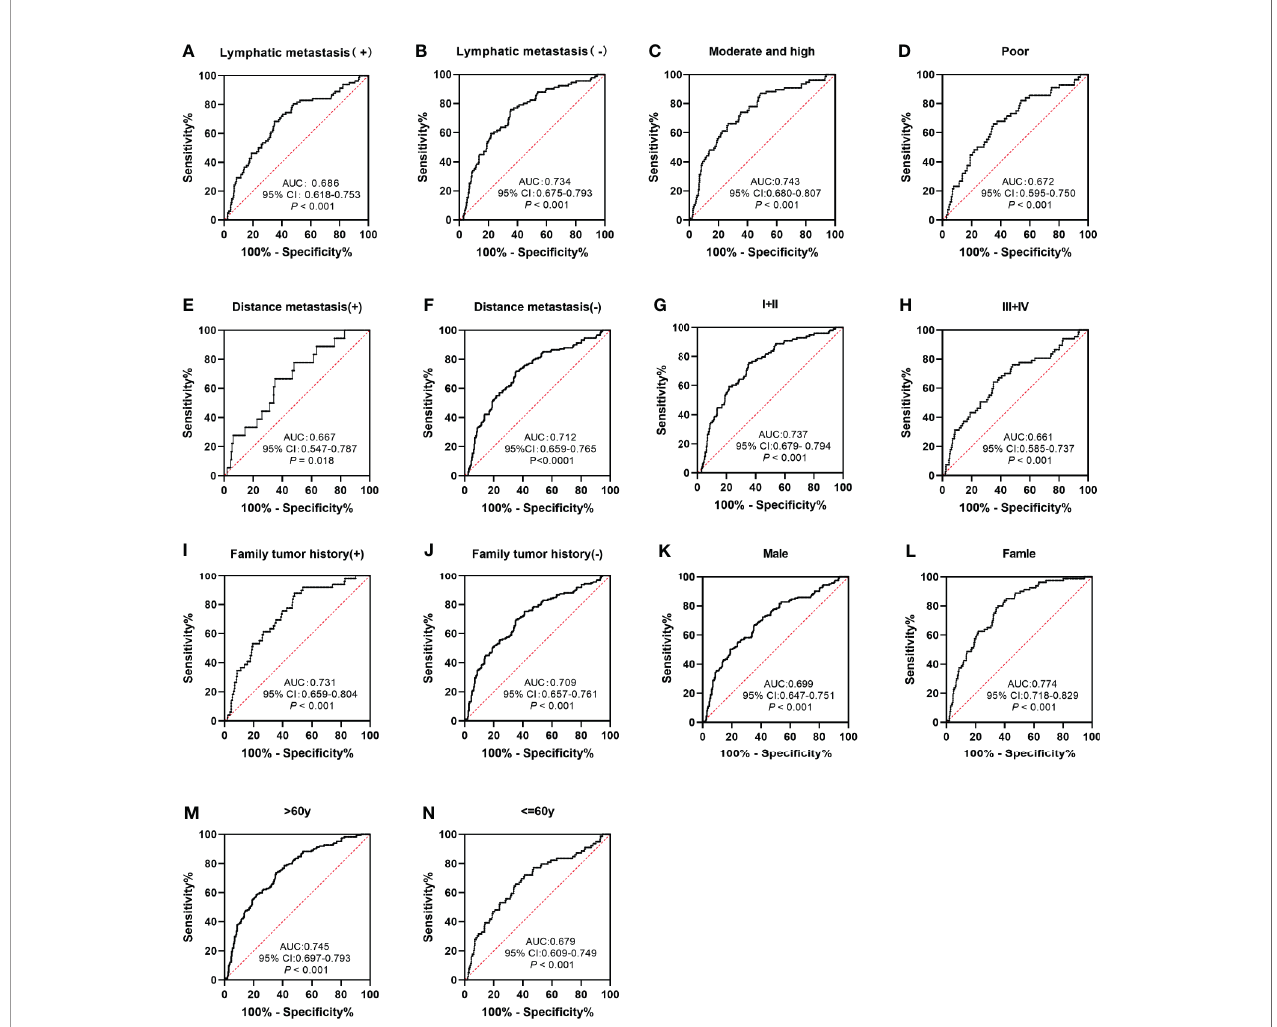
FIGURE 5 | The performance of anti-GNA11 autoantibody according to different clinical variables of ESCC patients. ESCC, esophageal squamous cell